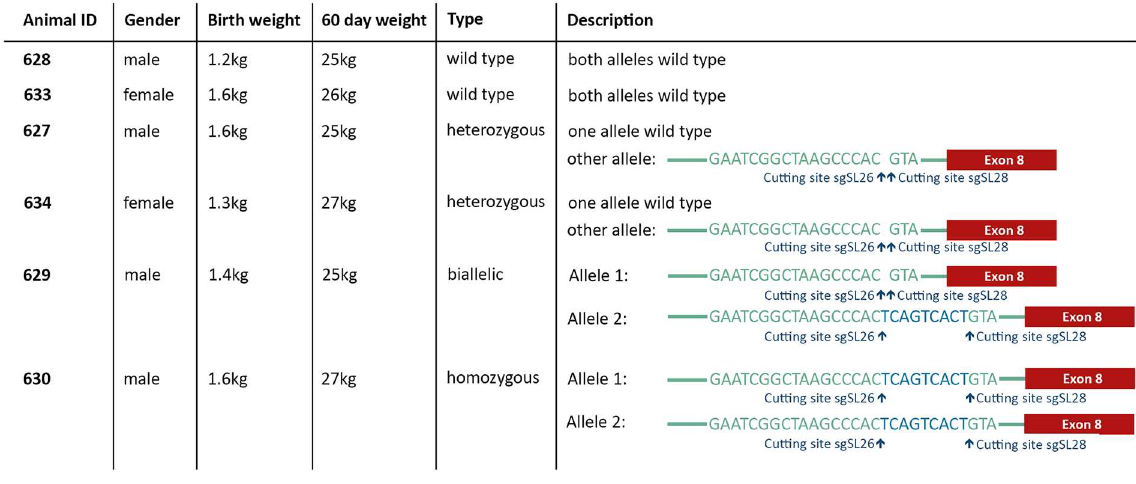
Fig 2. Genotypes and growth of assessedF1